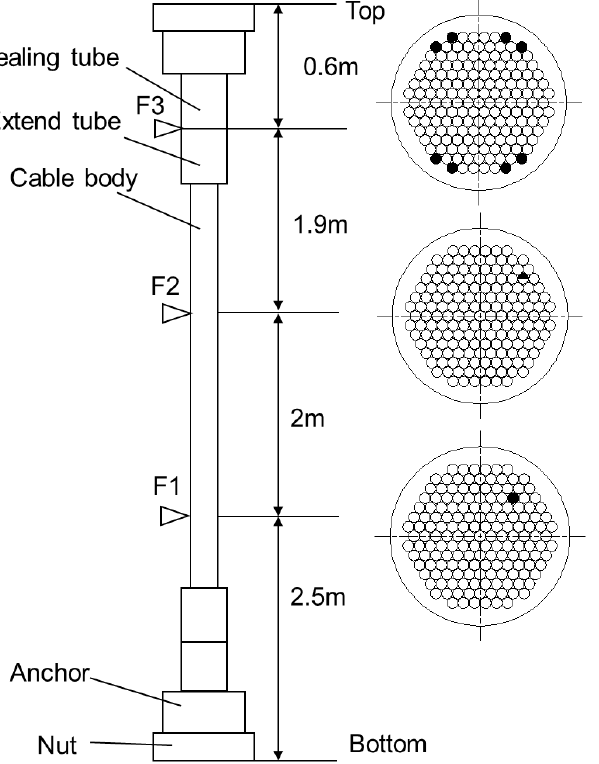
Figure 12. Schematic diagram of the sample